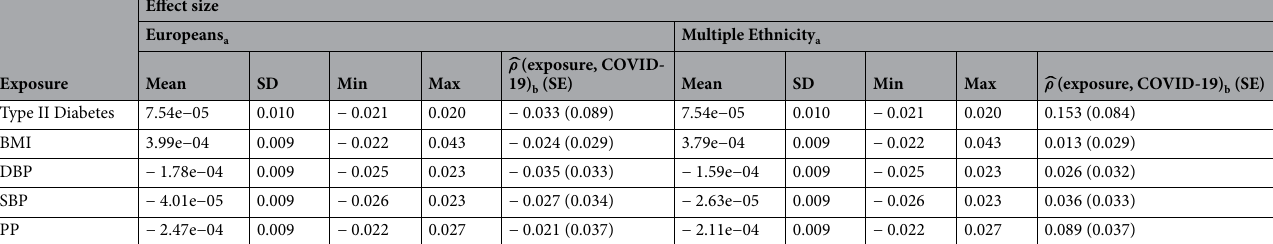
Table 1. Summary statistics for sizes of standardized effects of each exposure on COVID-19 hospitalization. Mean, standard deviation, minimum, and maximum values correspond to the sizes of the standardized effects of the selected SNPs on each exposure, calculated from original GWAS estimates using Eqs. (1) and (3) above. Correlation coefficients represent the correlations between exposure effect sizes and outcome (COVID-19 hospitalization) effect sizes, the latter of which is calculated from the original COVID-19 GWAS using Eqs. (2) and (4) above. All values are presented only for the final selected SNPs (i.e., those with a p-value less than 5e−8 and a linkage disequilibrium coefficient less than 0.1 in the original GWAS). Correlation coefficients ( a ) Estimates from the European set are from 2956 European individuals; estimates from the variable ethnicity set are from 10,908 individuals of either of European, African, Hispanic, or Middle Eastern descent. ( b ) the correlation between the effect sizes for each SNP’s estimated effect on the probability of the respective exposure or COVID-19 hospitalization after all mentioned exclusions (SNP independence, p < 5e−8, Pearson’s r < 0.1 with index SNP) were